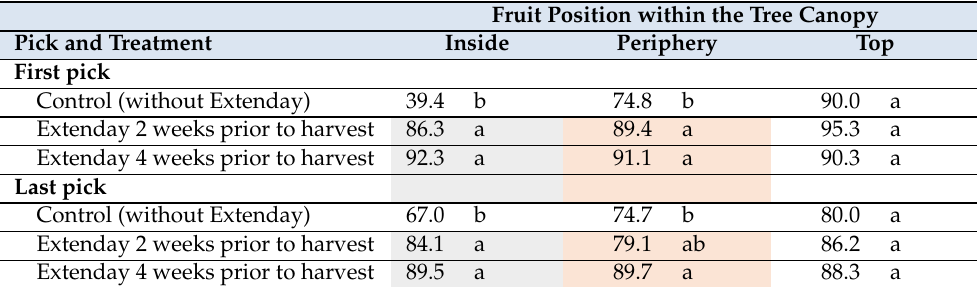
Table 2. Percentage blush of cv. Pacific Rose apple at each pick dependent on fruit position within the canopy. Fruit Position within the Tree